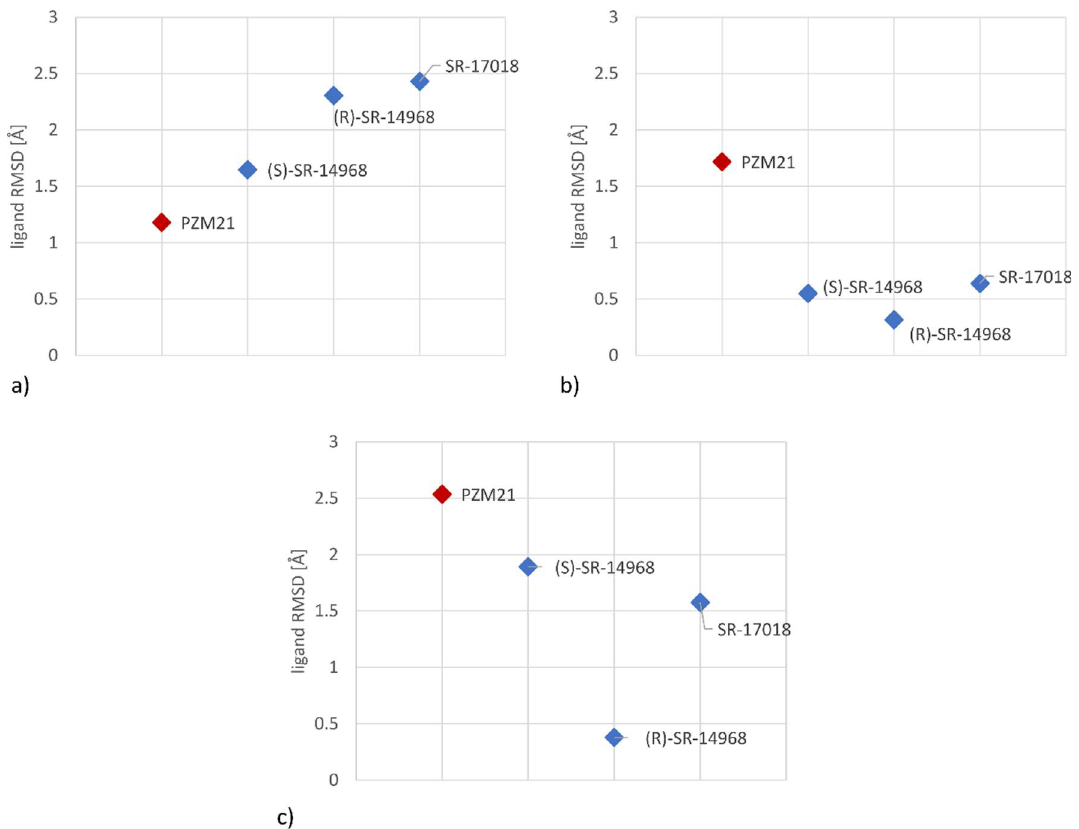
Figure 8. Analysis of the average ligand RMSD during MD simulations for ( a ) 4DKL, ( b ) 5C1M, ( c ) 6DDF crystal structures. The ligand RMSD values clearly indicate that SR compounds (depicted in blue) are more stably fitted in the activated μ-opioid receptor (simulations for 5C1M, 6DDF) in comparison to PZM21 (red). On the other hand, the situation is reversed for the 4DKL